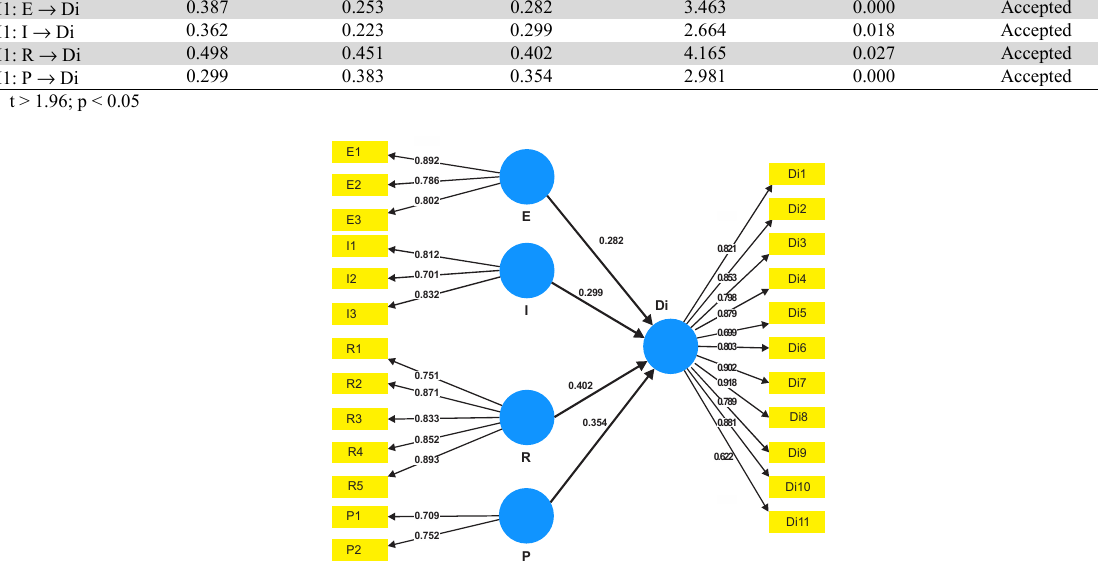
Fig. 3. Confirmatory structural